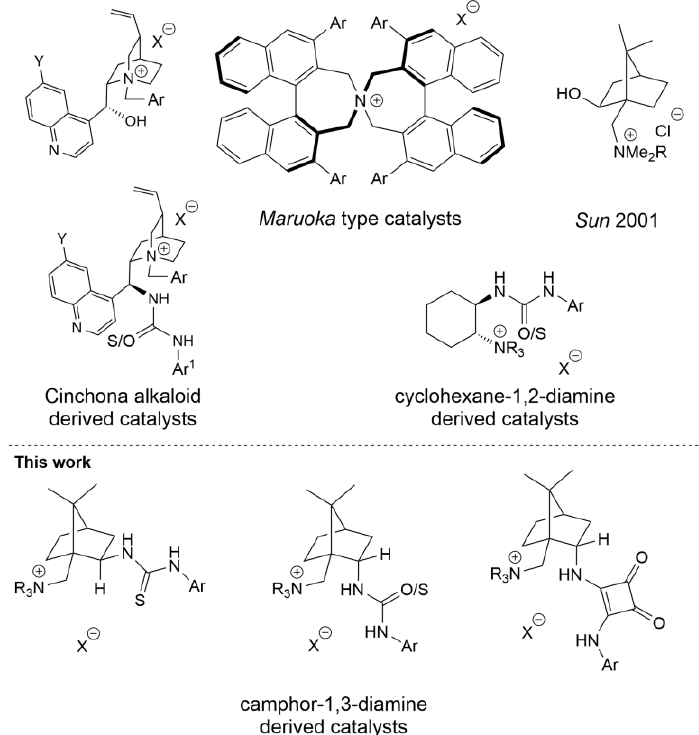
Figure 1. Selected efficient chiral quaternary ammonium salt phase-transfer catalysts (PTCs) and novel bifunctional camphor-based PTCs reported herein [20].